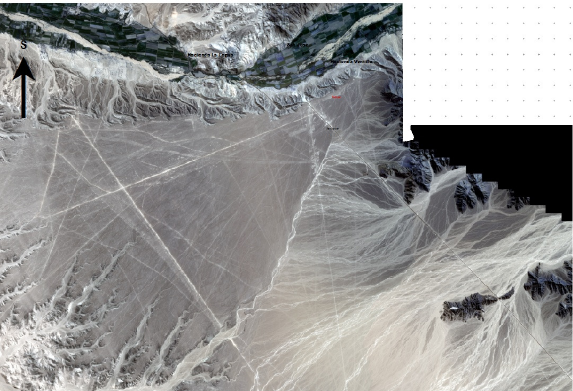
Figure 1. Under layer for creating the map –satellite image